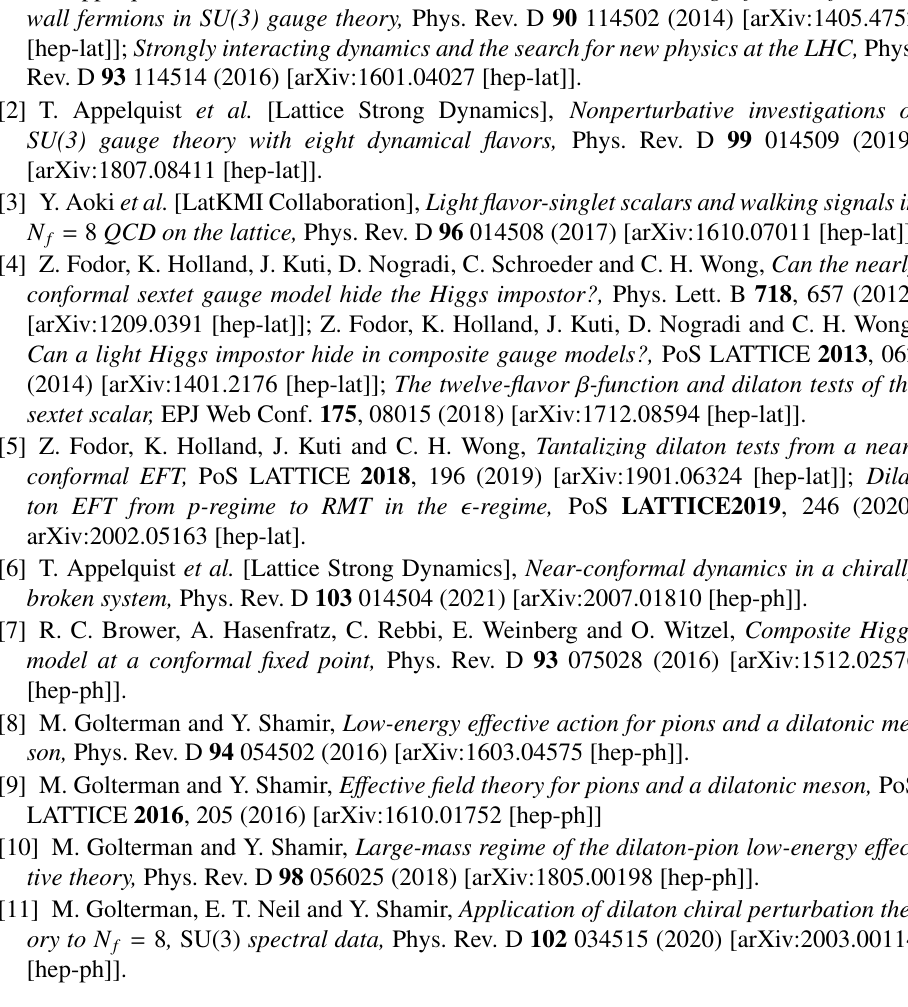
Figure 4. Fit of tree-level SdChPT to the taste splittings of Ref. [3]. Taken from Ref.